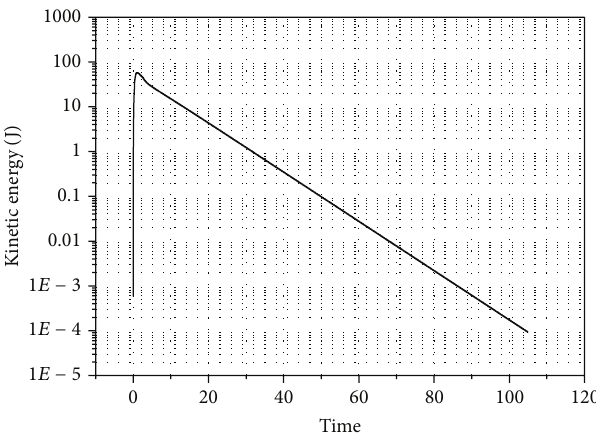
Figure 8: Kinetic energy of the 50-link